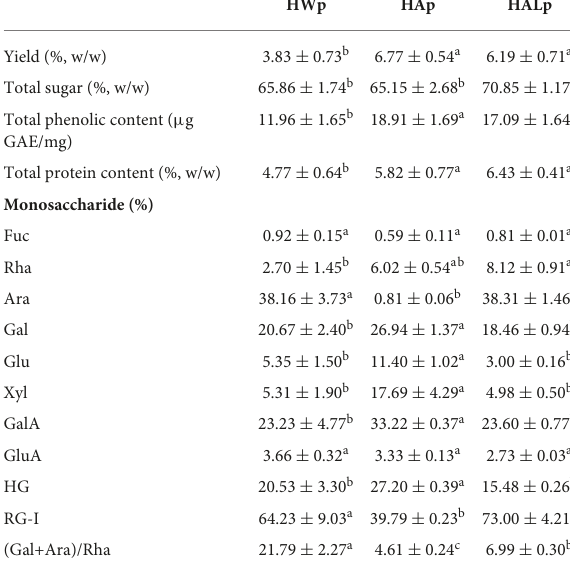
TABLE 1 Yields and the chemical compositions of HWp, HAp, and